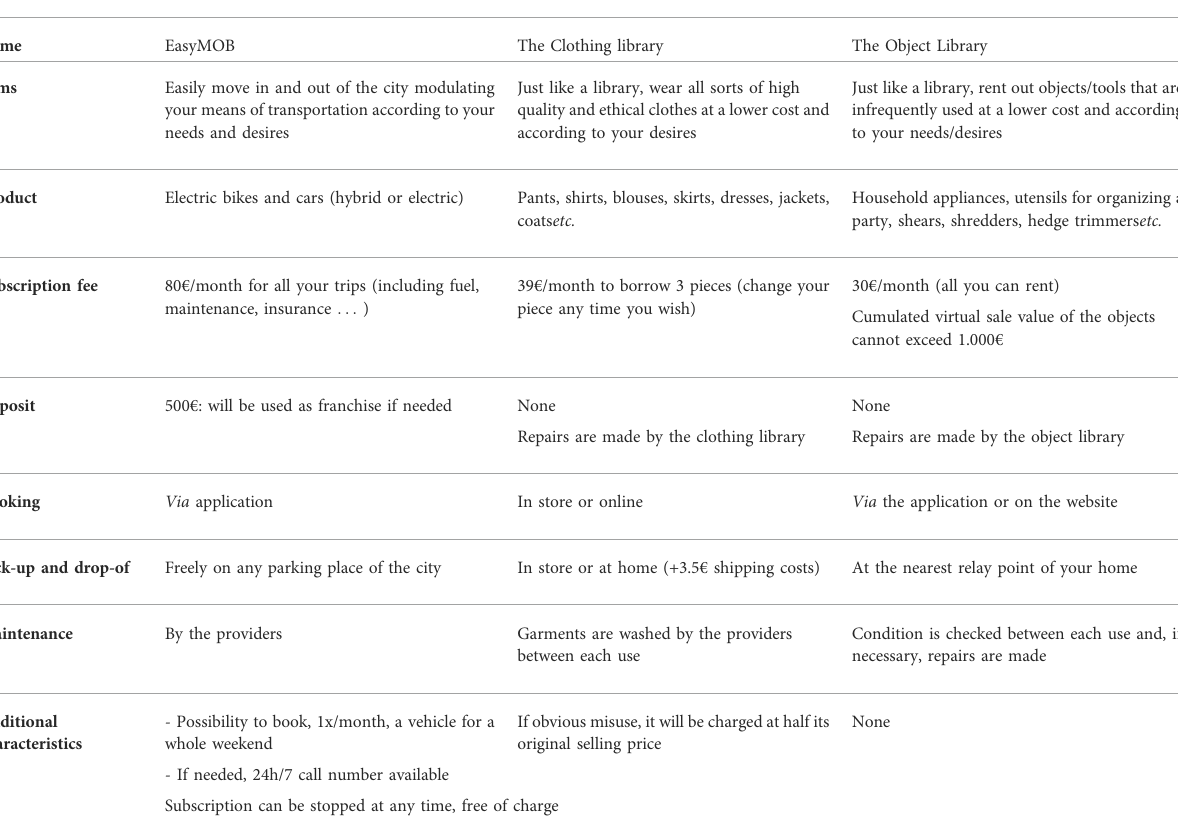
TABLE 1 Main elements of the survey PSS